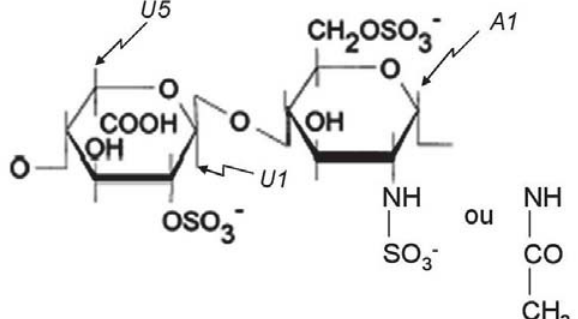
Fig. 2 - Estrutura da heparina. A heparina é majoritariamente constituída por unidades alternadas de ácido idurônico 2-sulfato e glucosamina N- e 6-disulfatada. Alguns resíduos da glucosamina estão N-acetilados. Os prótons facilmente identificáveis nos espectros unidimensionais de RMN são indicados no painel: U1 e A1 são os prótons anoméricos do ácido idurônico e da glucosamina, respectivamente, e U5 é o H5 do